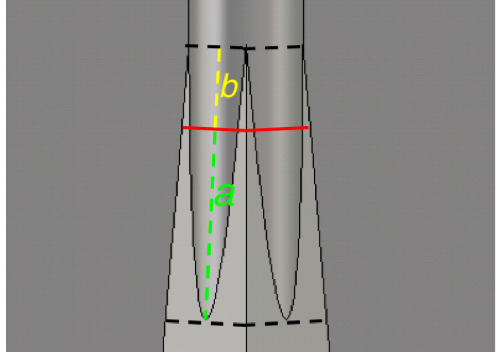
FIG. 2. Magnified top view of the transition between the pyramidal horn and the cylindrical waveguide. The red line indicates the cross section where the horn antenna ends and the cylindrical waveguide starts in the analytical model. a and b are the distances of the cross section from the apex and the cusp respectively of each ellipse (see text in Sec. II B).